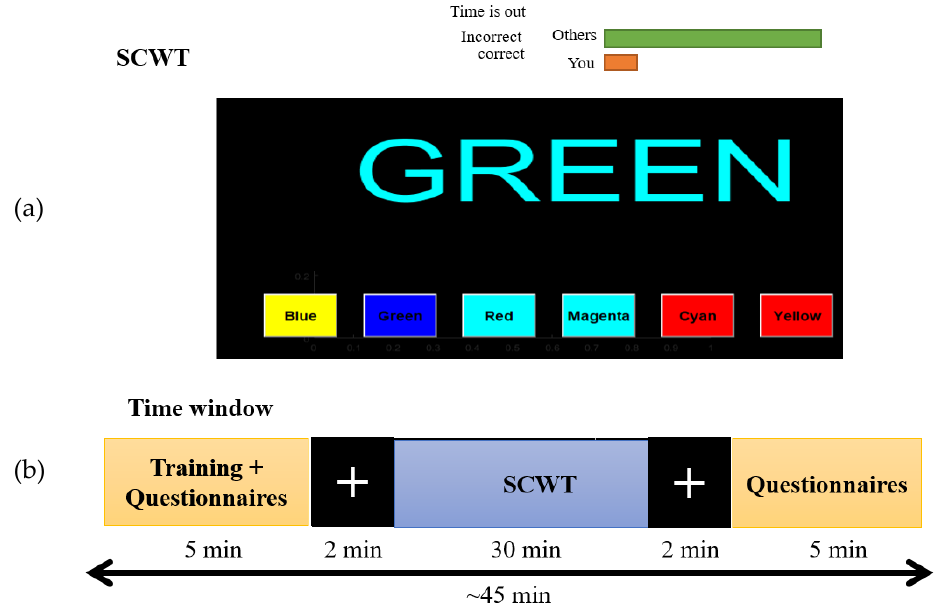
Figure 1. Experimental protocol ( a ) Stroop Color–Word Task (SCWT) presentation interface, and ( b ) timing window. In the timing window, the plus sign on the black background is for the pre- and post-baseline.